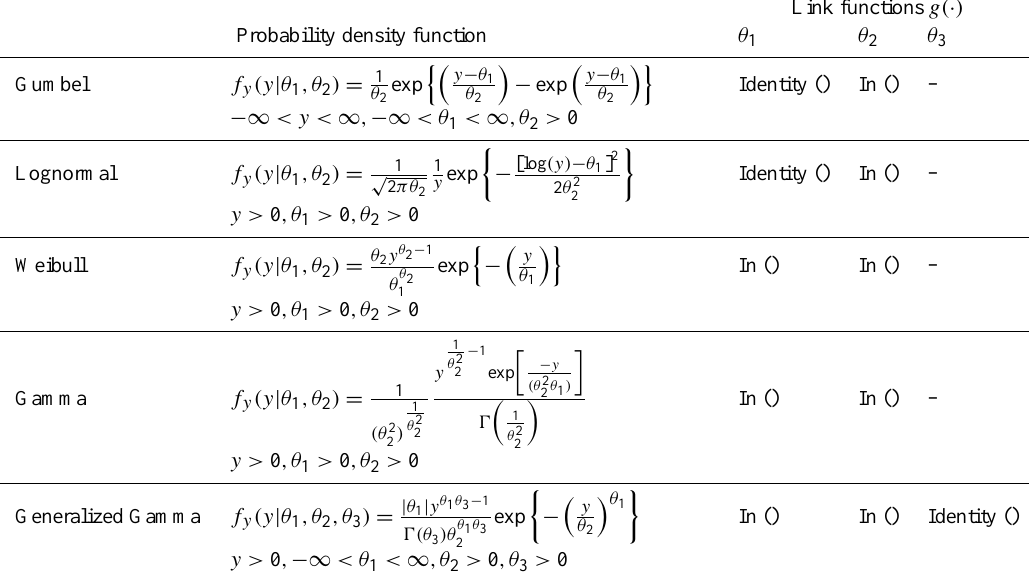
Link functions g( · )